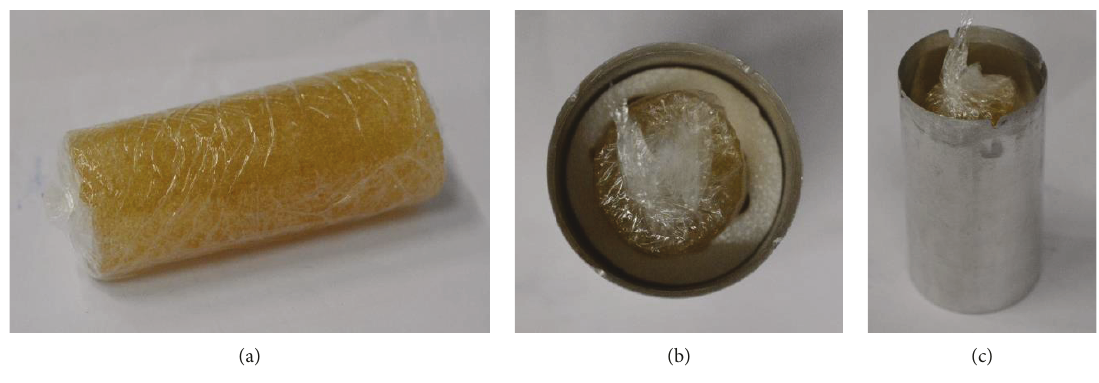
Figure 2: Gelatin bird projectile and the